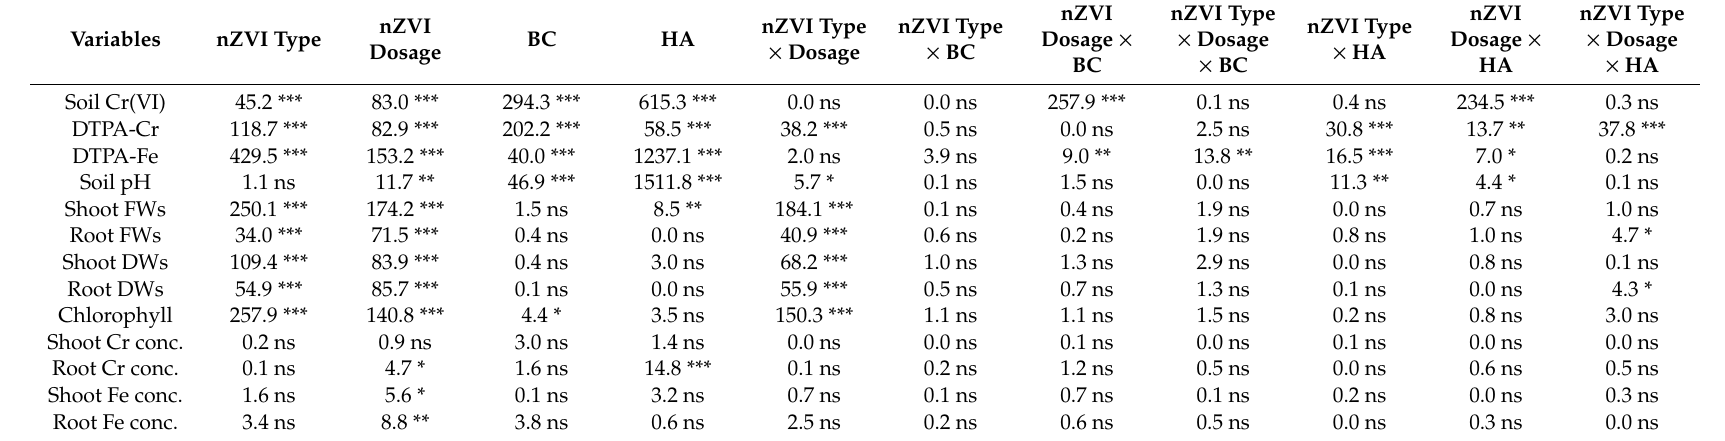
Table 2. Significance levels ( F values) of nZVI type and dosage, BC or HA addition level and their interactions on measured variables in a three-way ANOVA analysis. Variables